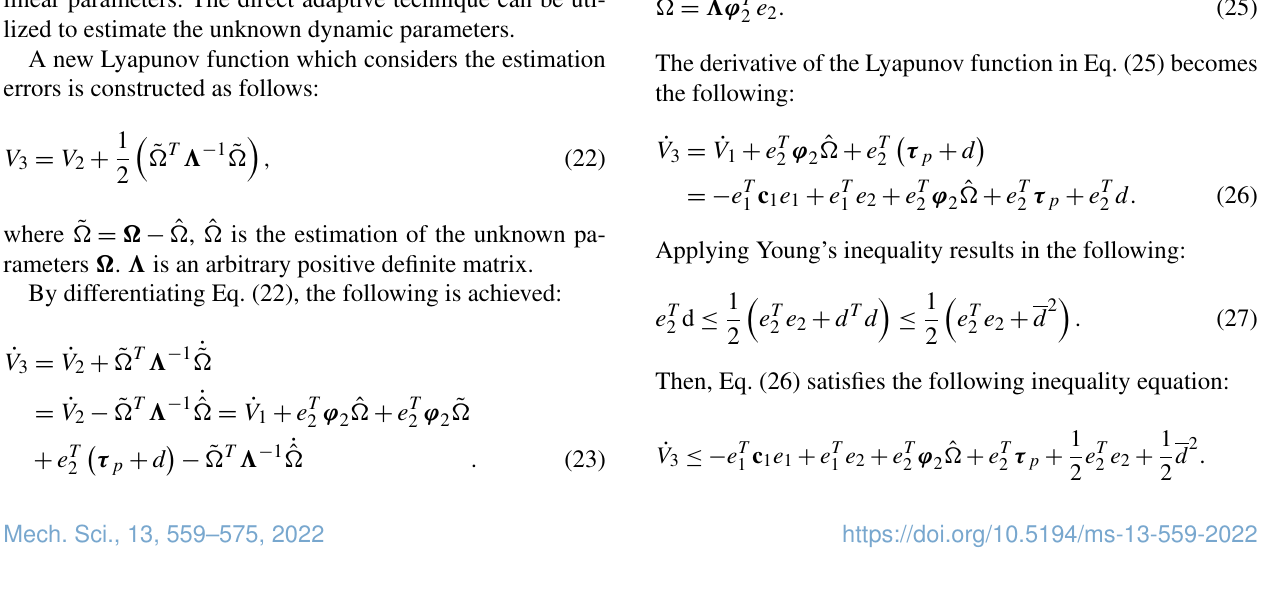
The unknown parameters on the right side of Eq. (20) can